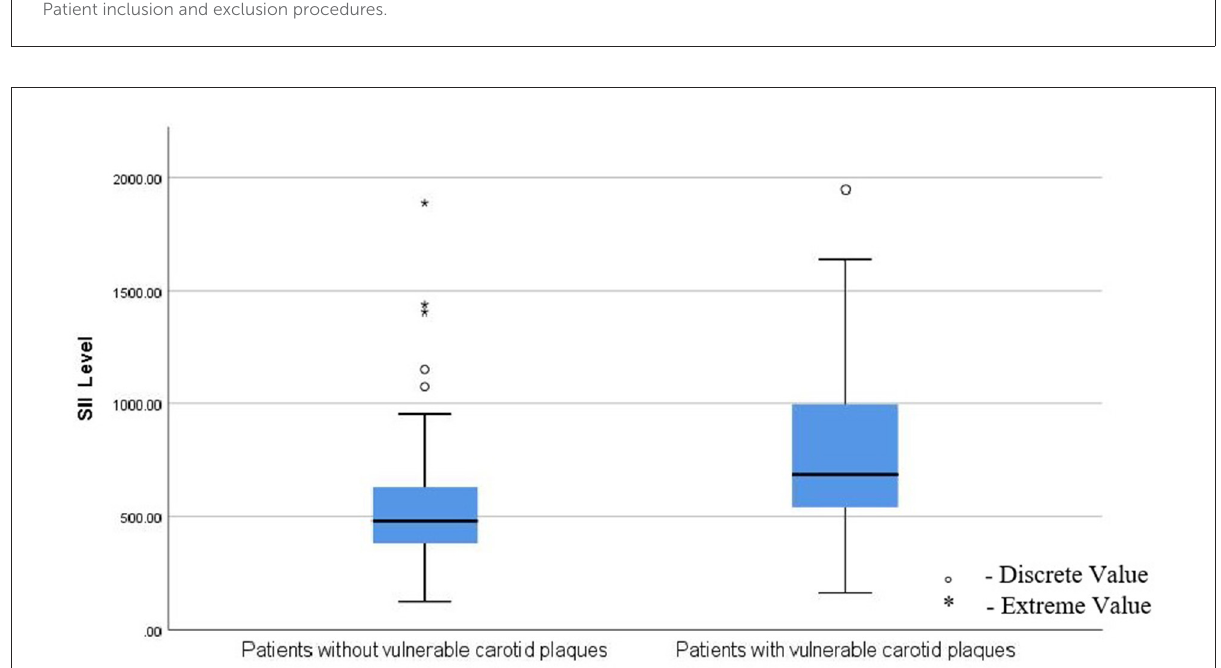
FIGURE2 Patients in the vulnerable plaques group had higher levels of SII than those in the stable plaques group; SII, Systemic immune-inflammation index. ◦ means: Discrete value. * means: Extreme